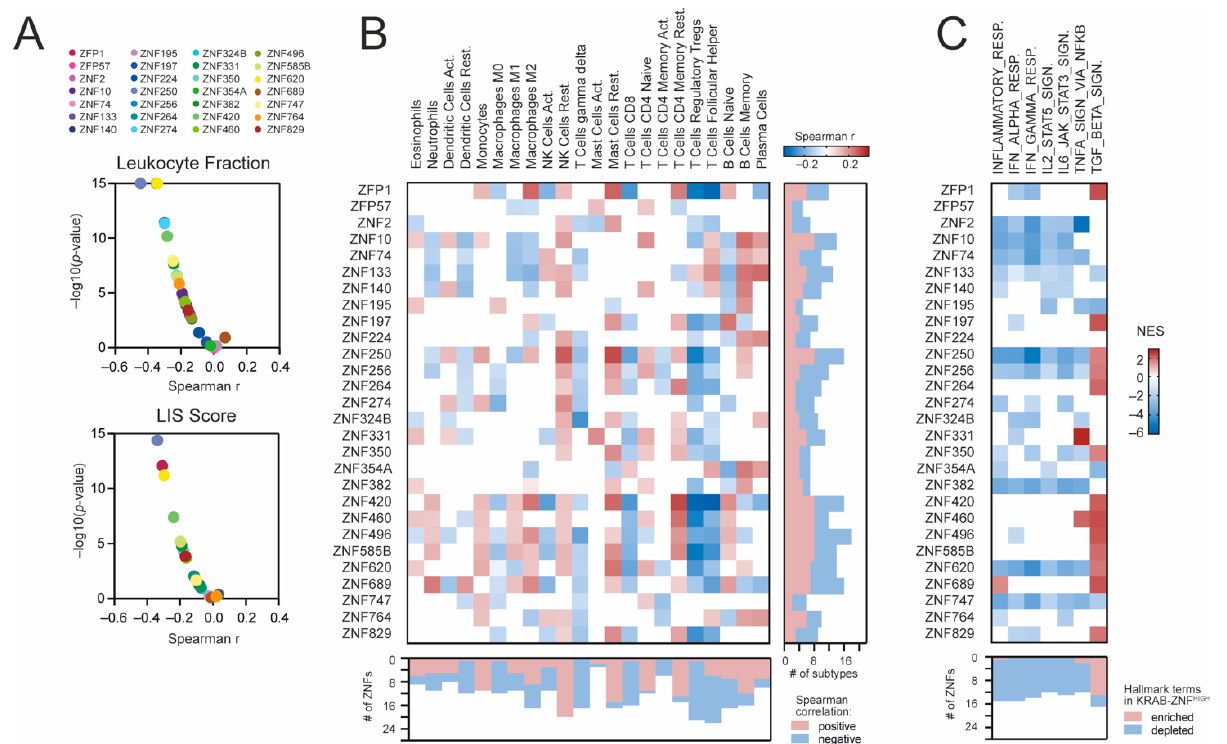
Figure 6. The association between KRAB-ZNF expression and the immune cell infiltration in KIRC. ( A ) The Spearman correlation of the leukocyte fraction (upper panel) or the lymphocyte infiltration signature (LIS) score (bottom panel) and KRAB-ZNF expression in TCGA KIRC patients. ( B ) The Spearman correlation of immune cell infiltration level with the expression of KRAB-ZNFs in KIRC. Blue and brown present negative and positive correlations, respectively. The right panel denotes the number of immune cell subtypes positively (brown) or negatively (blue) associated with the expression of distinct KRAB-ZNFs. The bottom panel denotes the number of KRAB-ZNFs positively (brown) or negatively (blue) associated with the abundance of distinct immune cell subtypes. ( C ) The heatmap presents the normalized enrichment scores (NES) for 7 selected immune-associated Hallmark terms (v7.4) from the GSEA analysis of KRAB-ZNF-associated transcriptome profiles. White—no statistical significance ( p > 0.05) or no DEGs detected. The bottom panel denotes the number of KRAB-ZNF-associated transcriptome profiles with either enriched (brown) or depleted (blue) immune-associ- ated terms.